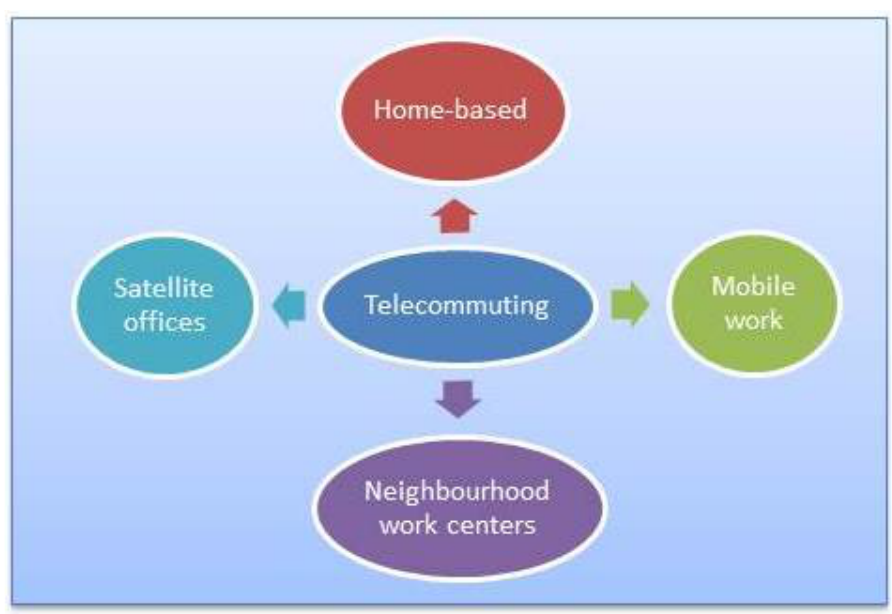
Figure 1. Leading forms of